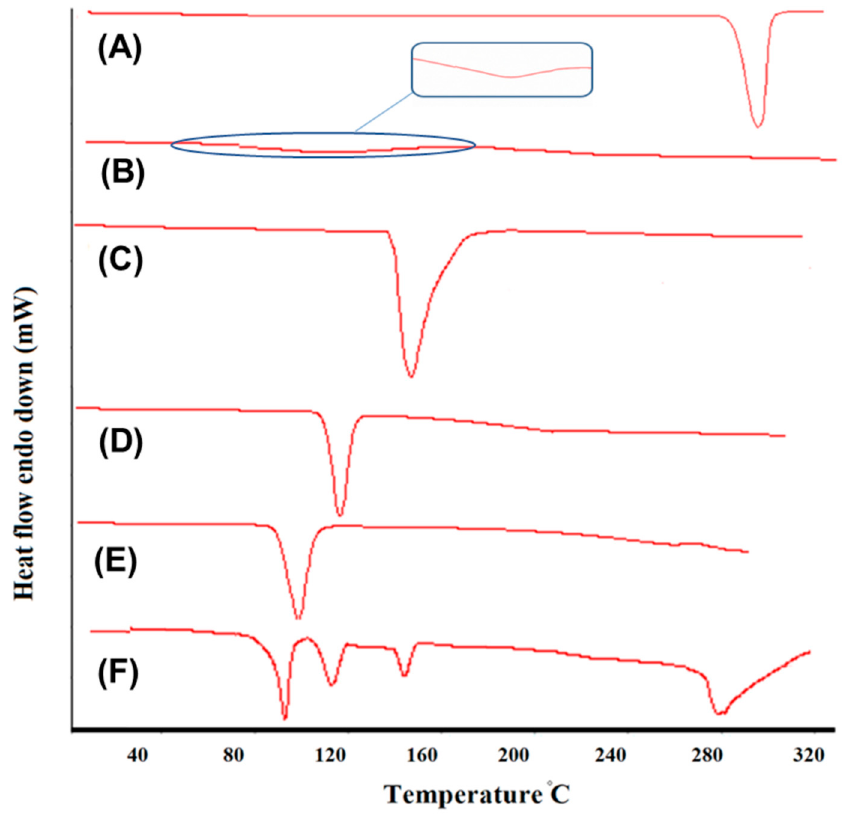
Figure 3. DSC thermogram of ( A ) DTB; ( B ) Carbopol ETD 2020; ( C ) sodium meta bisulphite; ( D ) methyl paraben; ( E ) propyl paraben; ( F ) physical mixture .